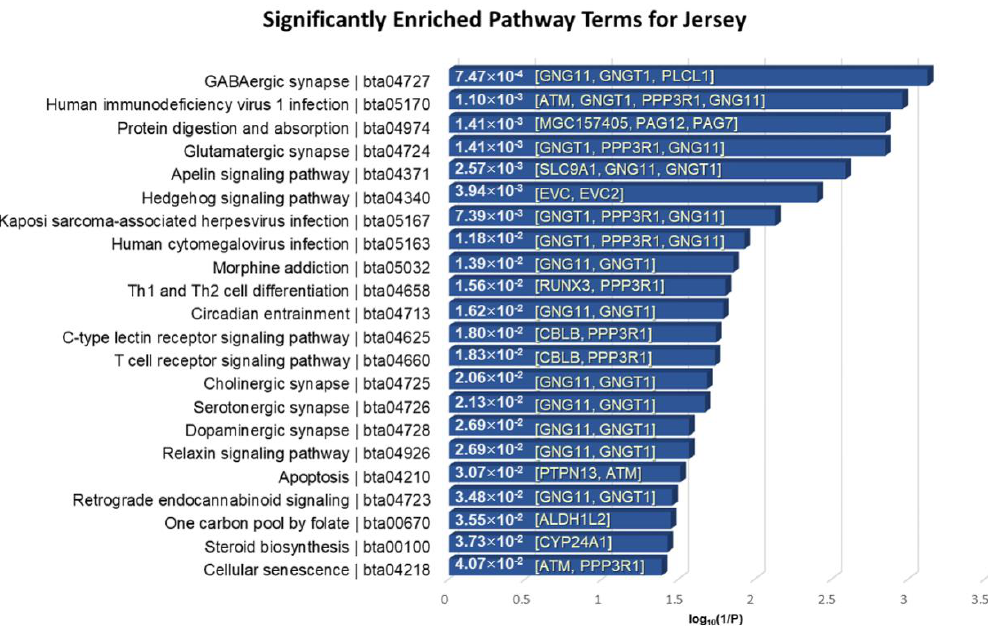
Figure 7. KEGG pathway enrichment analysis of the 40 overlapped genes in the Angus breed. The x -axis is the log10(1 / p -value), and the annotated genes of the enriched pathways with significant p -values shown in bar graphs.